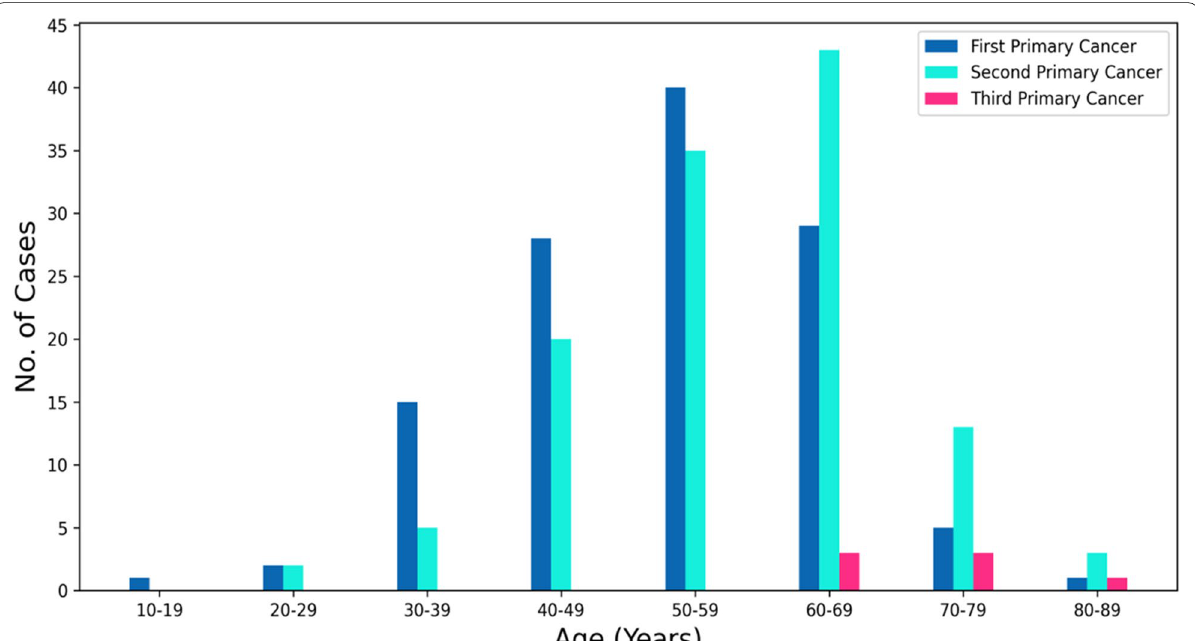
Fig. 1 Graph depicting the age of the first, second and third primary cancer patients at the time of MPMTs diagnosis (MPMTs* multiple primary malignant